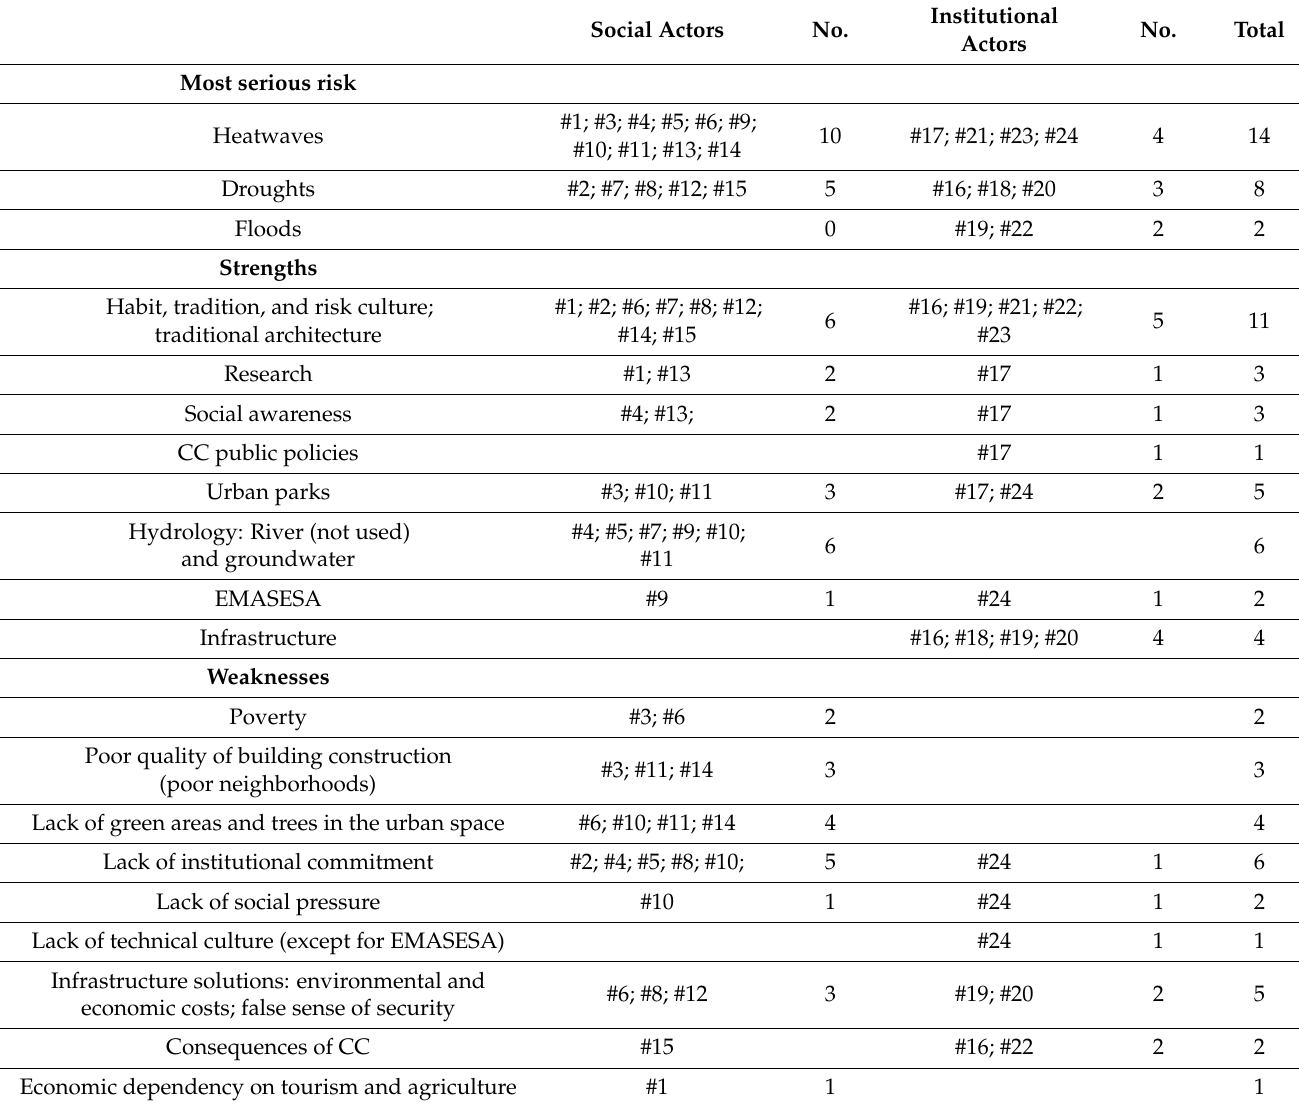
Table 3. Synthesis of interview